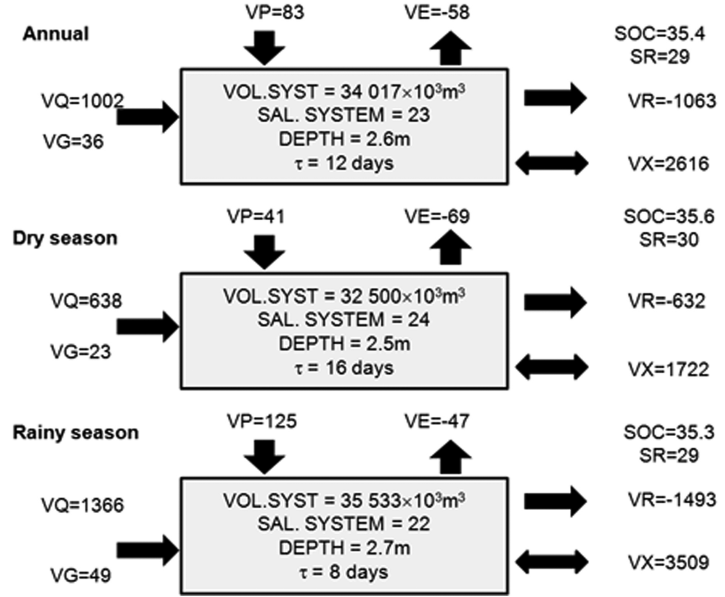
Fig. 3 – Annual and seasonal water (10 3 m − 3 d − 1 ) and salt flux (10 3 psu) budgets, and residence time ( τ = Vol estuary /(V X |V R |), in days) at the BJE. ( + ) indicates source, and ( − ) indicates